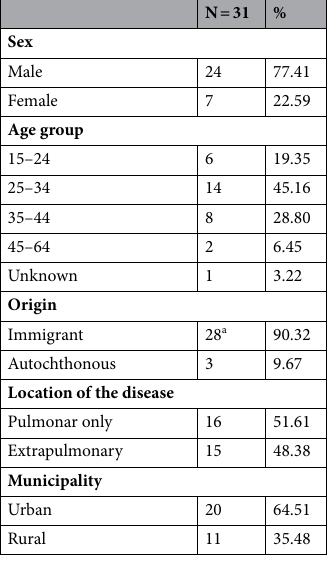
Table 1. Patients’ characteristics whose isolates were identified as M. africanum in Aragon from 2003 to 2019. a 27 immigrants came from West African countries and one came from Bulgaria.